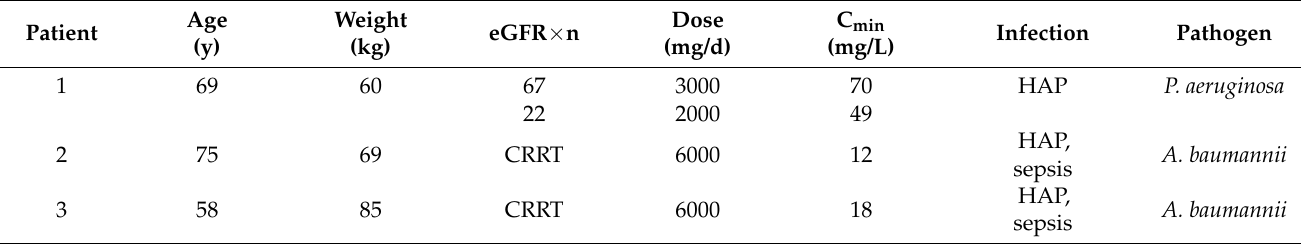
Table 2. Patient characteristics and cefiderocol measurements.